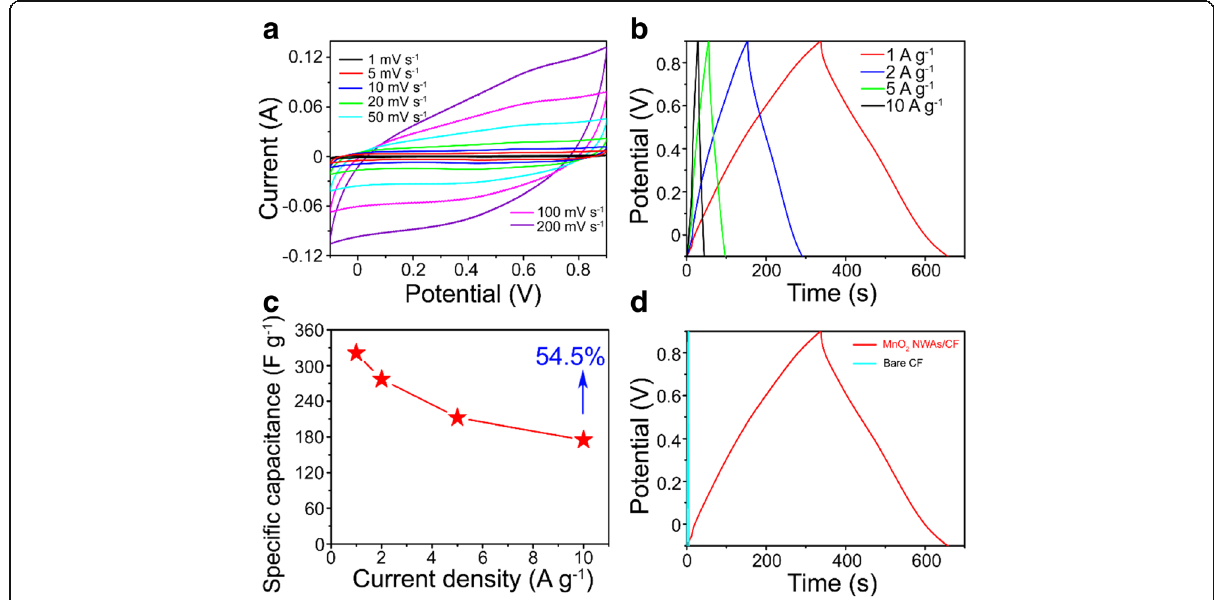
Fig. 3 a CV curves of the CF@MnO 2 NWA electrode under different scan rates. b Galvanostatic charge-discharge curves of the CF@MnO 2 NWA electrode at different current densities. c Specific capacitance of the CF@MnO 2 NWA electrode as a function of the current density. d Galvanostatic charge-discharge curves of the CF@MnO 2 NWA and the bare CF at a current density of 1 A g −